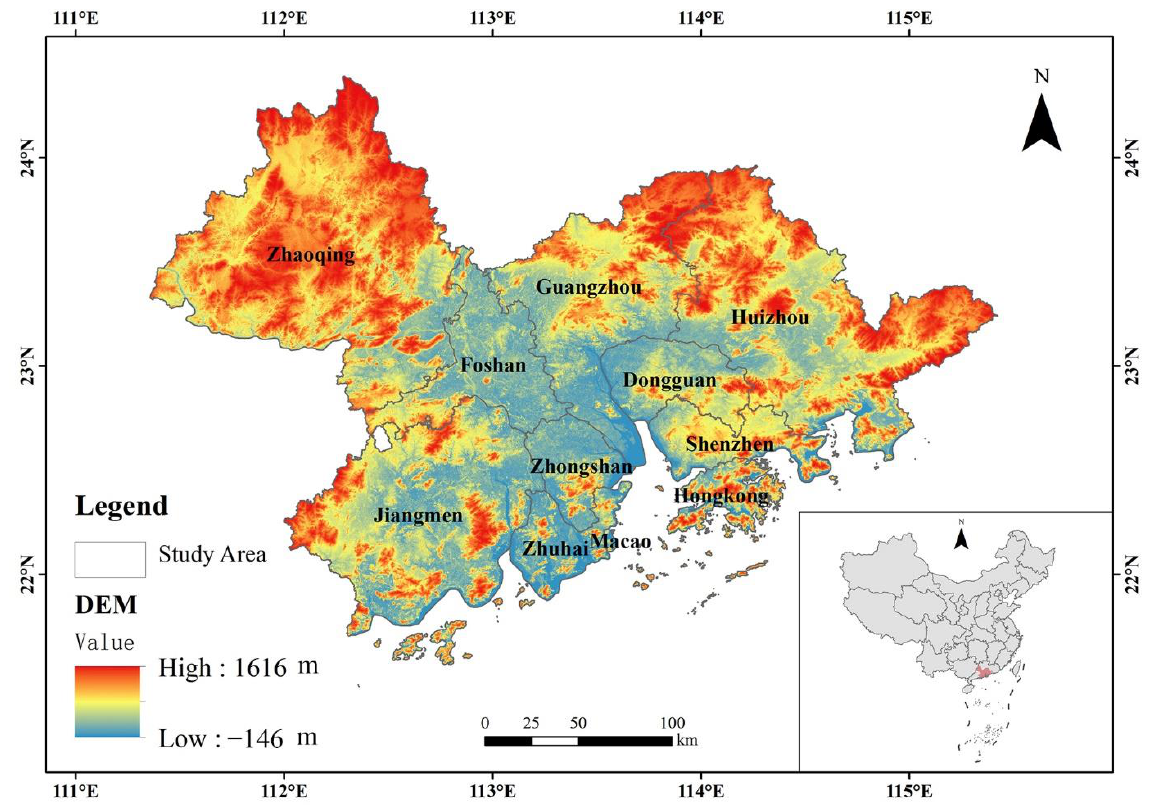
Figure 2. Geographical location of study area.